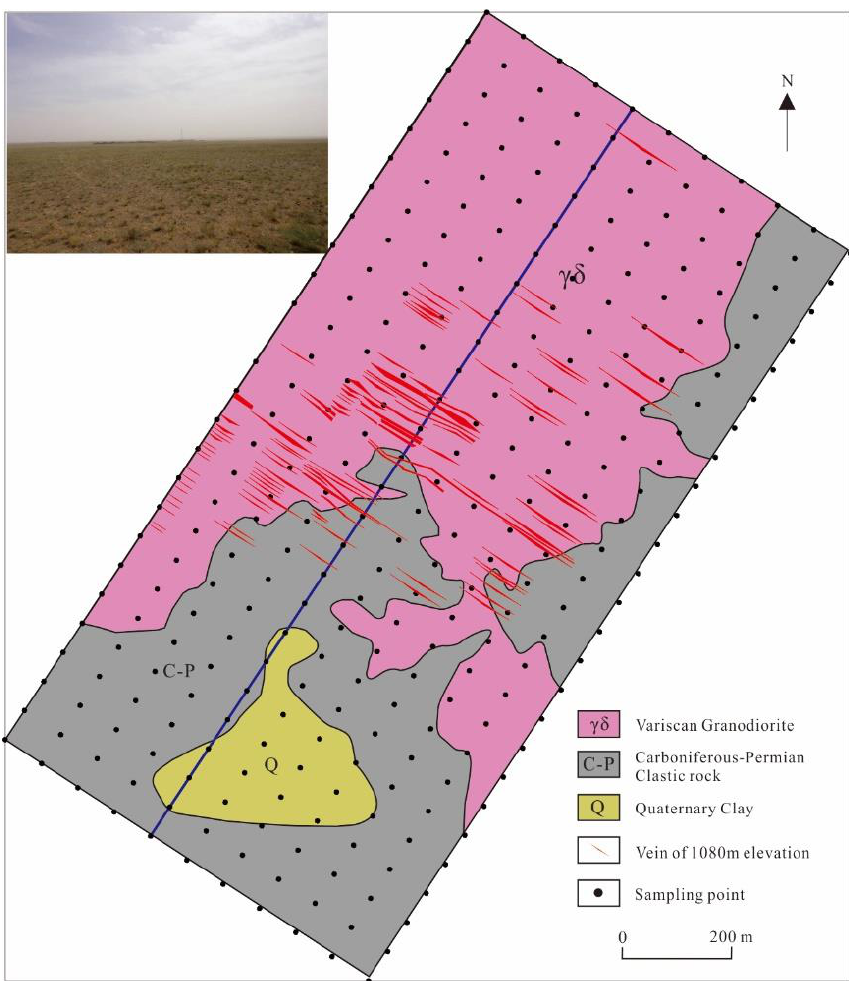
Figure 3. Geological sketch map (modified after Zhang et al. [21]) and sampling sites of the Zhunsujihua Cu-Mo deposit.